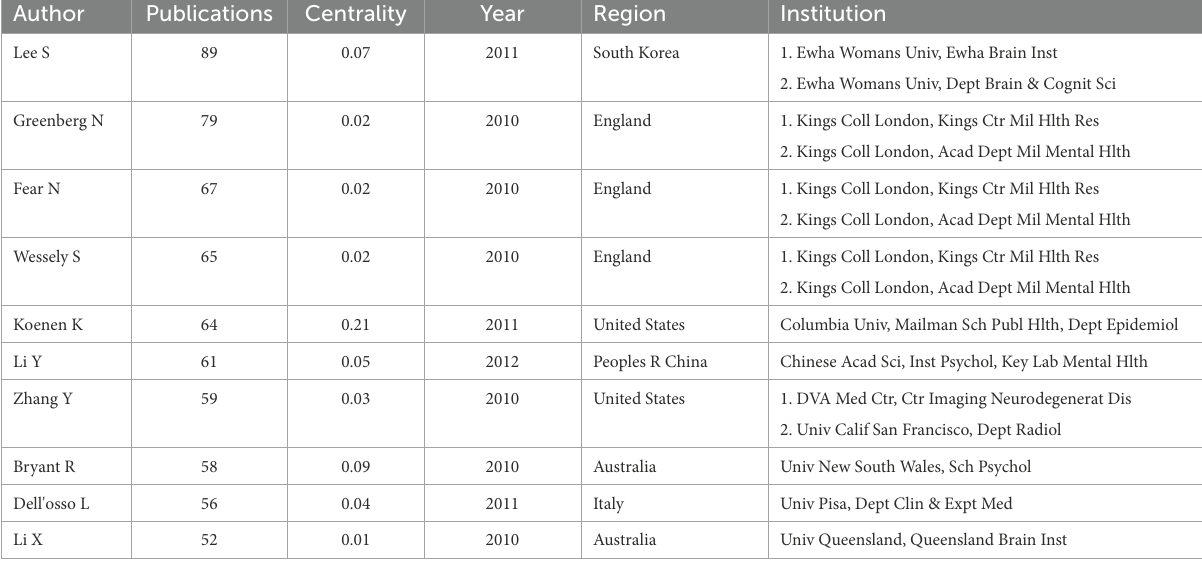
TABLE 2 Top 10 prolific authors on